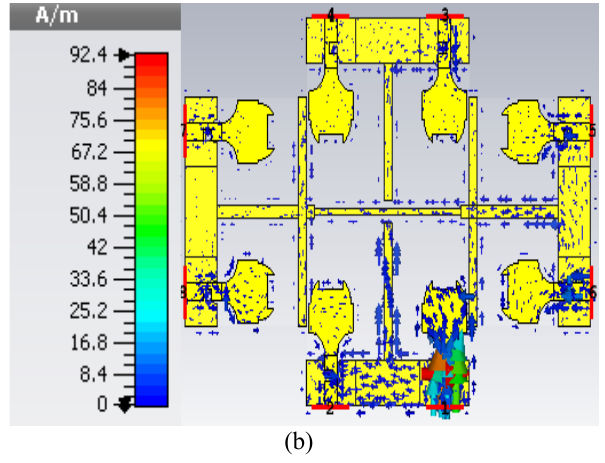
FIGURE. 8 Current distribution of the proposed MIMO antenna at 4 GHz, (a) without the isolation-enhanced technique, (b) with the isolation-enhanced technique